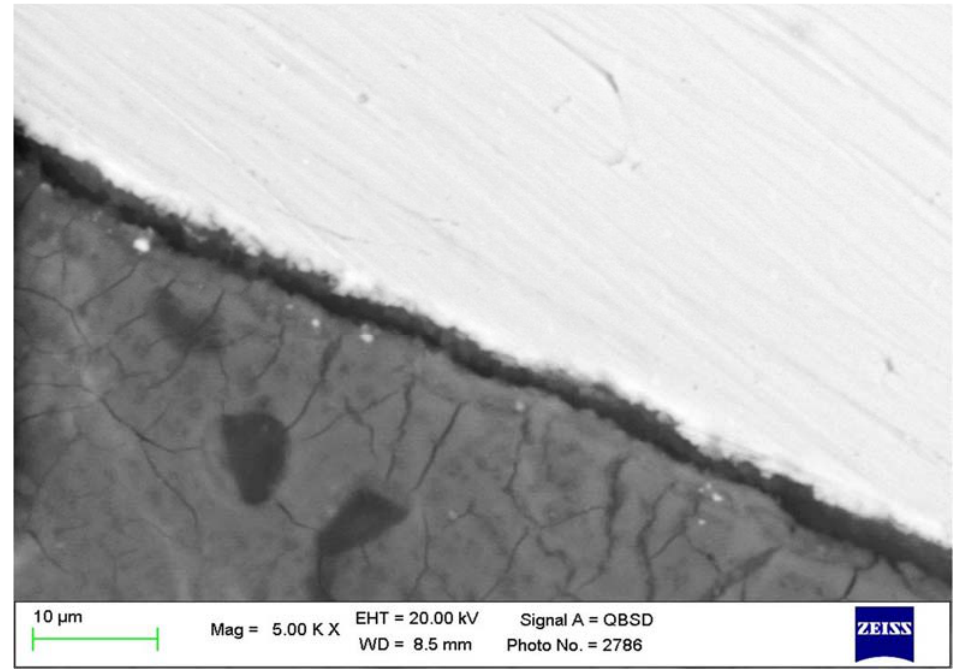
Figure 4. ESEM microanalysis at 5000x magnifications, revealing a low electron-dense layer between the implant and the bone tissue. This layer was detected along the bone–implant interface, with a size ranging from 3 to 18 μ m.